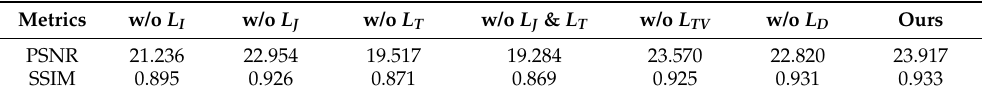
Figure 11. Qualitative ablation study for the loss function on a real-world hazy image dehazing. ‘w/o’ is the abbreviation of ‘without’. Table 7. Quantitative ablation study for the loss function on the HSTS dataset [38]. ‘w/o’ is the abbreviation of ‘without’. The best value of the specific metric is in boldface.